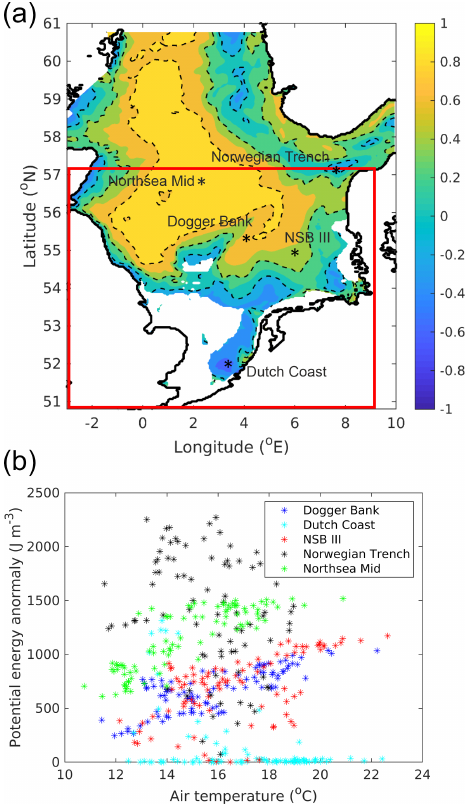
Figure 8. (a) Computed correlation coefficient R between the air temperature and the potential energy anomaly for summer 2018 (June, July and August). Note that the area with no stratification ( φ < 50Jm − 3 ) is excluded. Dashed contours indicate R = 0 , 0 . 4 and 0 . 8. (b) Relationship between the air temperature and the poten- tial energy anomaly in the different regimes of the North Sea. The locations are illustrated in (a) . The red frame indicates the region of the southern North